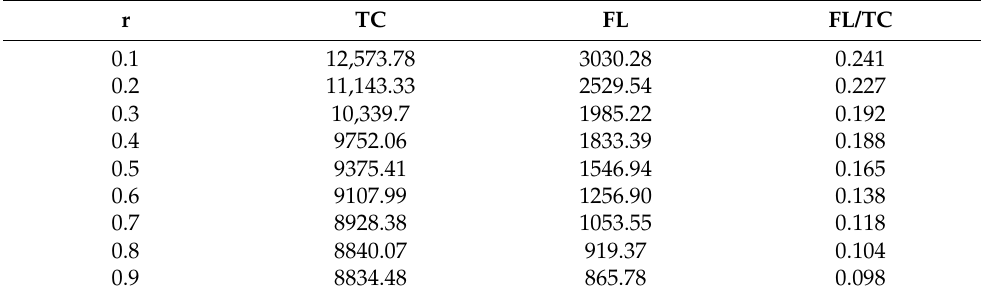
Table 4. The impact of different regulatory factors on